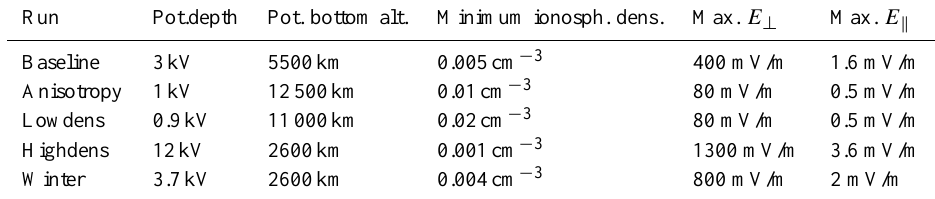
Table 2. Run state at t = 700s